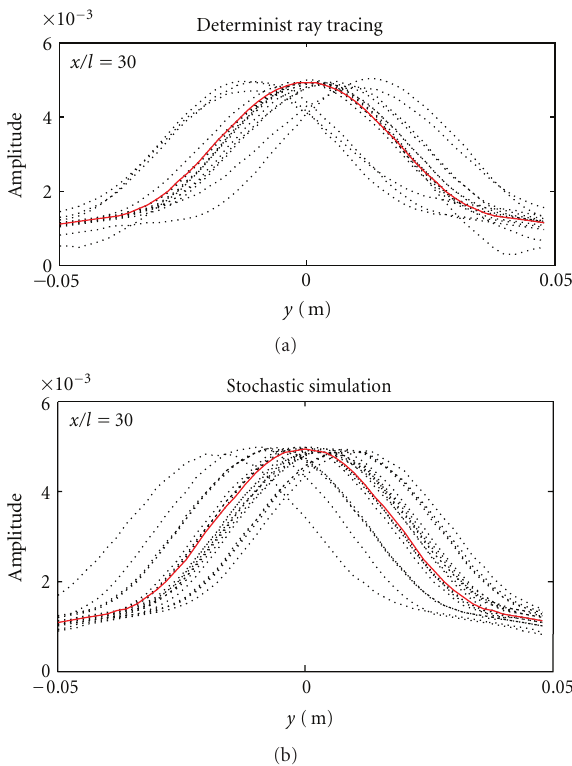
Figure 11: Acoustic beam deviations for the determinist and stochastic models; result for the homogeneous model is in